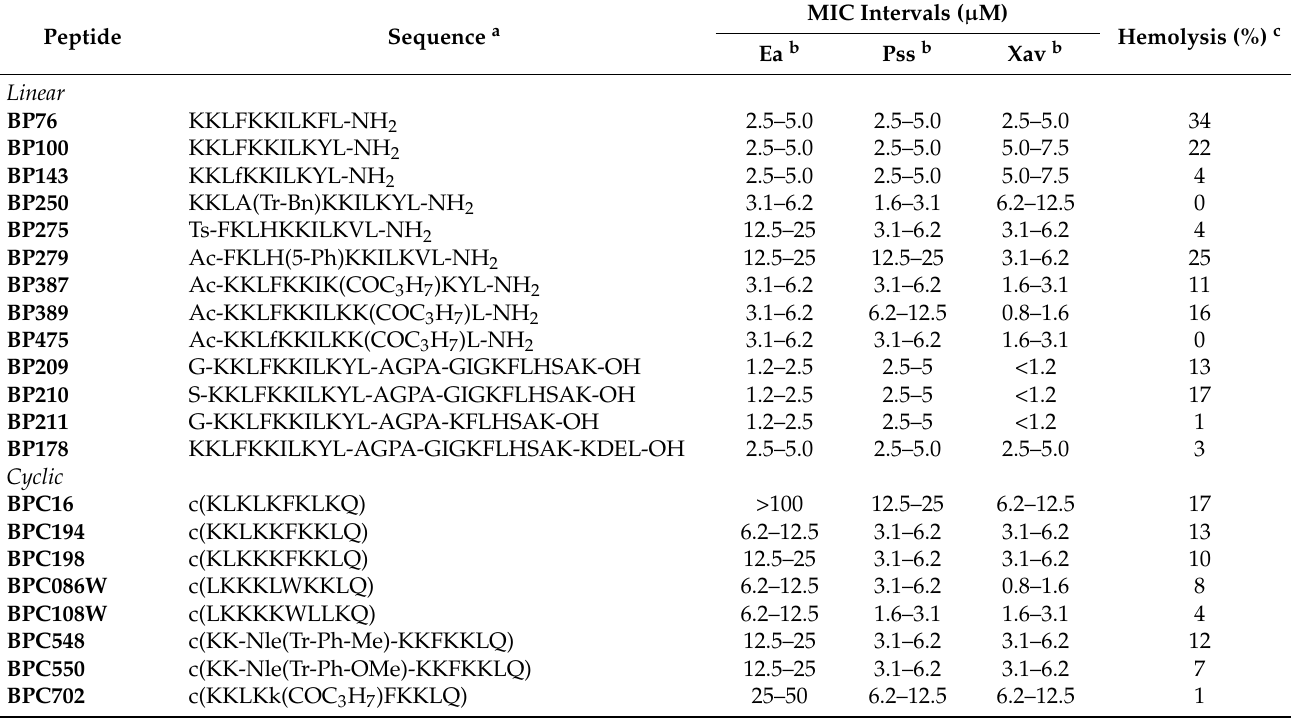
Table 1. Antimicrobial activity (minimum inhibitory concentration, MIC) and hemolysis of selected linear and cyclic